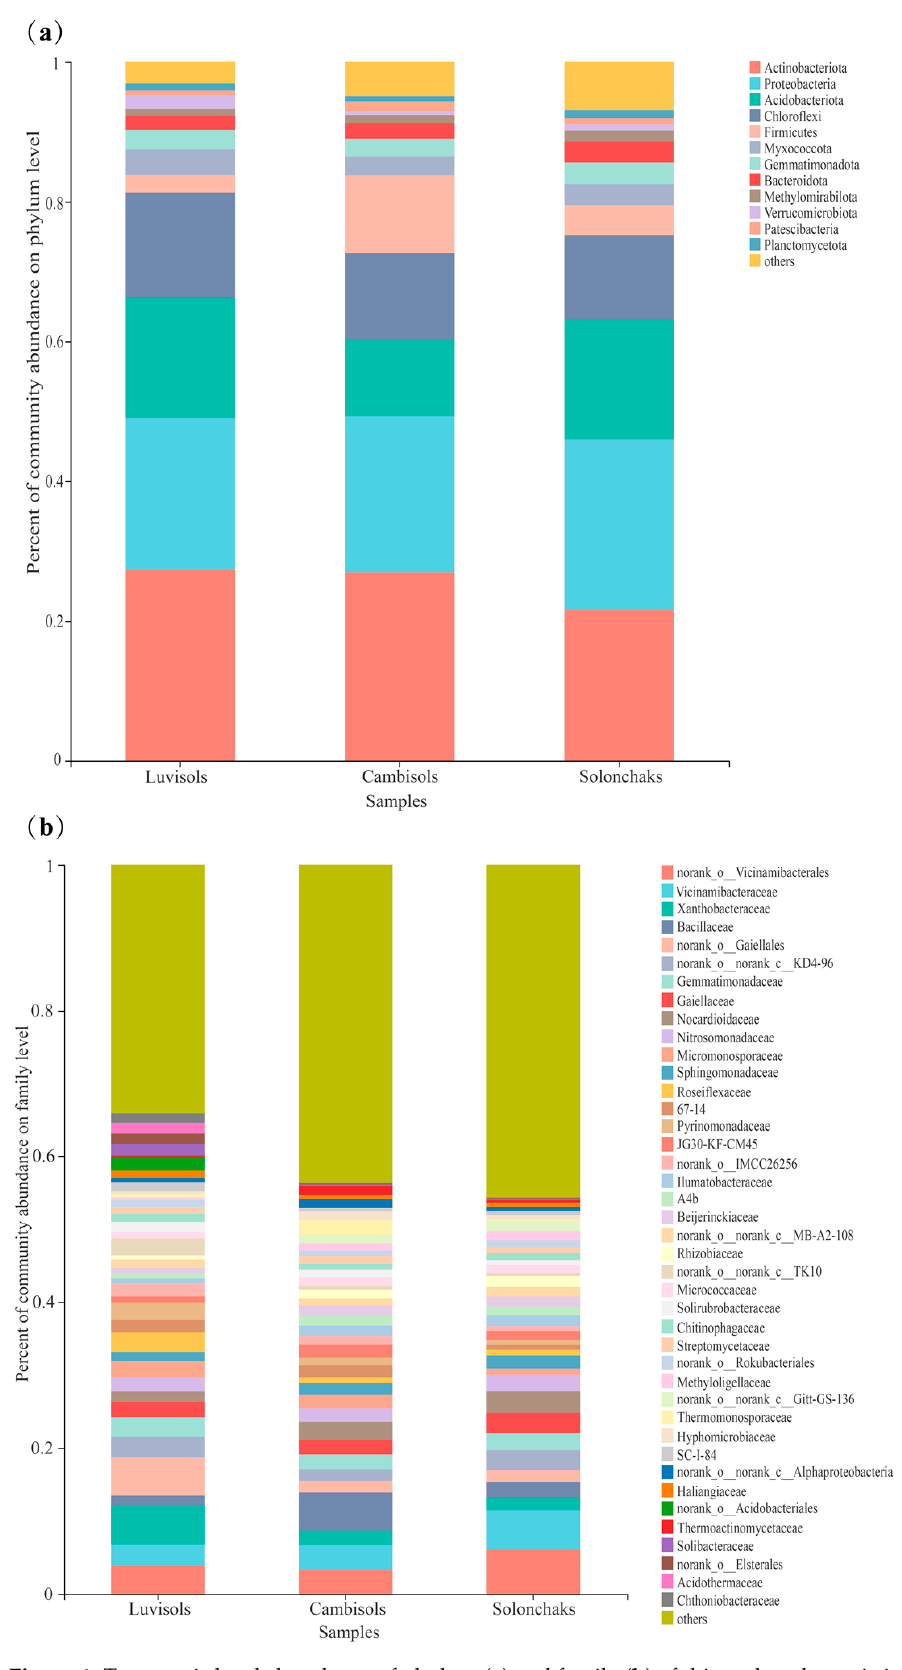
Figure 1. Taxonomic level abundance of phylum ( a ) and family ( b ) of rhizosphere bacteria in different soil types of pecan